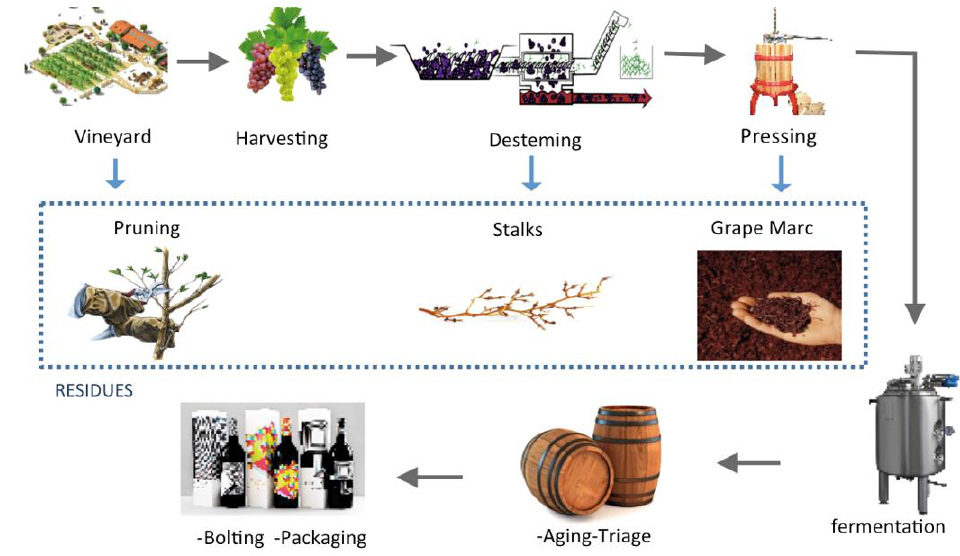
Figure 1. Main stages of vinification, where lignocellulosic residues are generated.